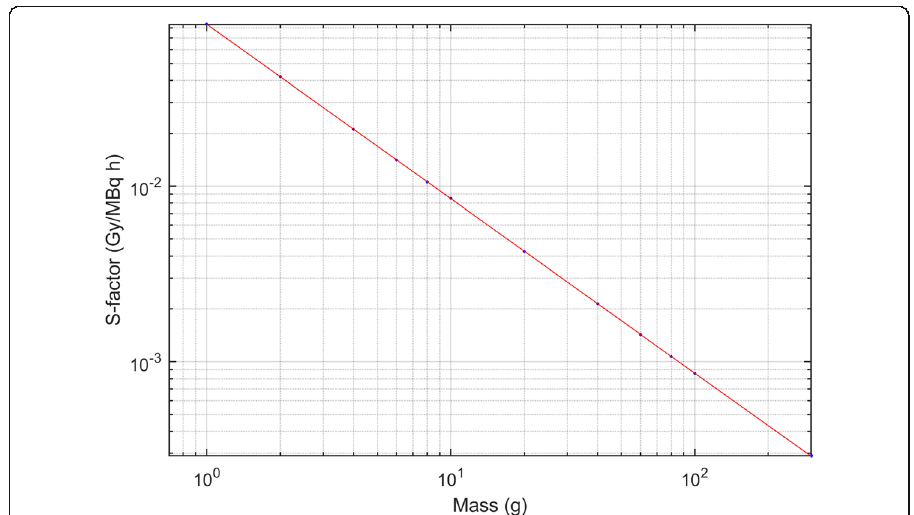
Fig. 1 S-factors against mass for unit density